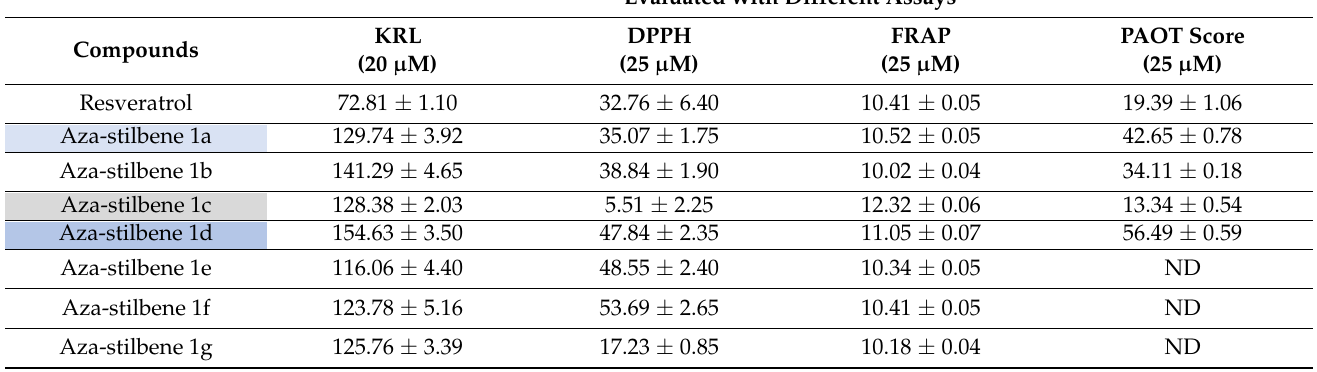
Table 2. Antioxidant activities of resveratrol and